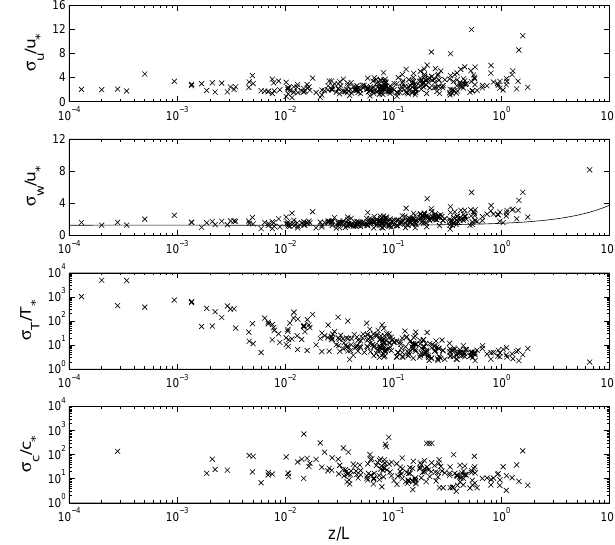
Fig. 4. Same with Fig. 3 except calculated after removing seven IMFs to contribute at low frequency. The solid line is provided by Kaimal and Finnigan (1994) ( = 1 . 25 ( 1 + 0 . 2 z/L) 0 c 0 , and u ∗